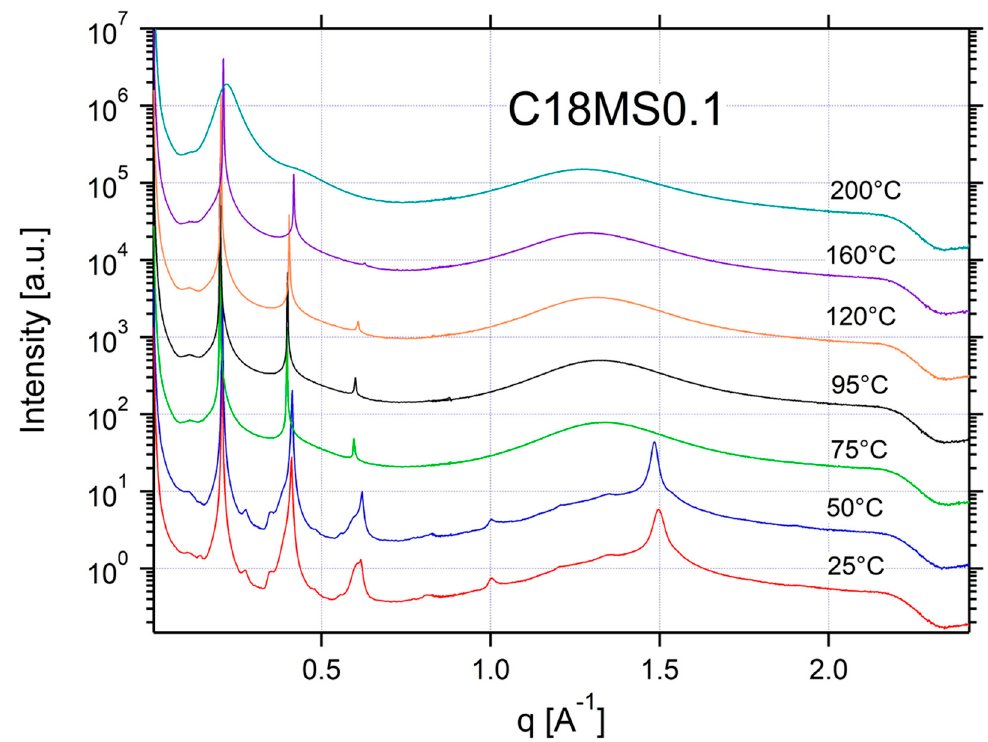
Figure A12. SAXS and WAXS data for 0.1:1 C18MS:C18LiTFSI.